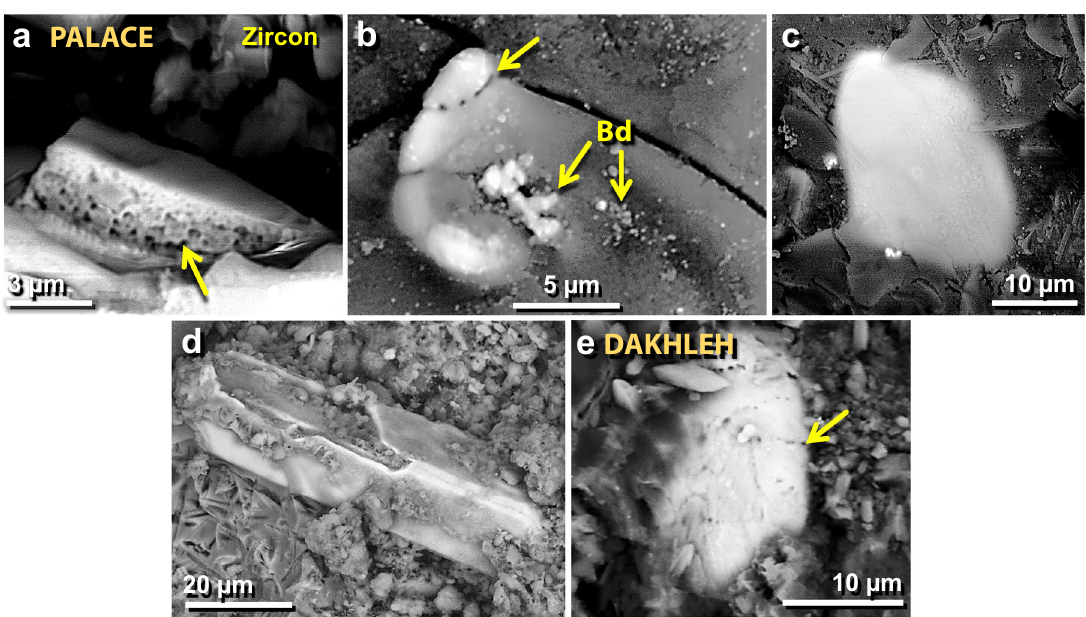
Figure 30. SEM images of melted zircon grains. ( a ) Melted TeH zircon grain with bubbles at yellow arrow due to high-temperature dissociation and/or entrapped porosity. ( b ) Melted TeH zircon grain decorated with bubbles along the fracture line at upper arrow; arrows labeled “Bd” point to bright granular baddeleyite, ZrO 2 , formed during the high-temperature dissociation of zircon. ( c ) Almost fully melted TeH zircon grain mixing into the Ca–Al–Si matrix. ( d ) A typical unmelted zircon grain from TeH with straight, euhedral edges. Grain shows cracks on the top surface from possible thermal or mechanical damage. ( e ) For comparison, from cosmic airburst/impact at Dakhleh Oasis in Egypt: melted zircon decorated with lines of bubbles